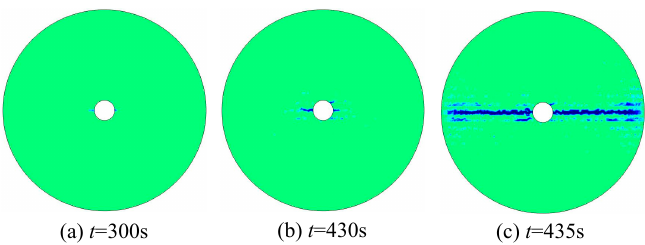
Figure 8. Fracture network evolution versus time in numerical simulation: ( a ) 3.78 MPa; ( b ) 5.52 MPa; and ( c ) 5.58 MPa.